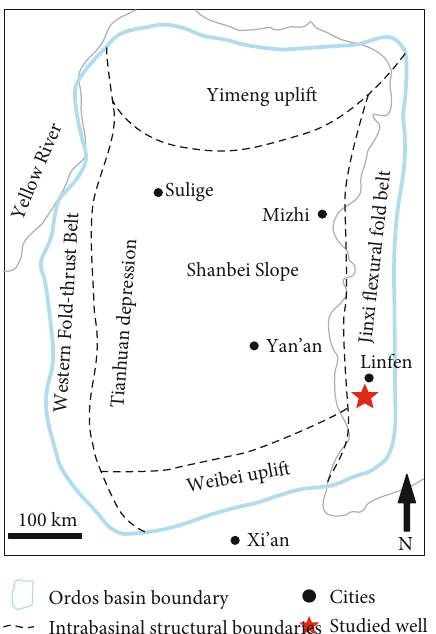
Figure 1: Tectonic map of the Ordos Basin and location of the study well.